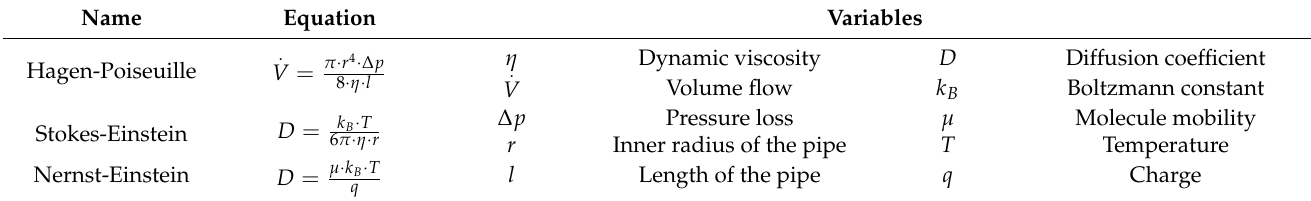
Table 2. Summary of viscosity-influencing equations for RFB